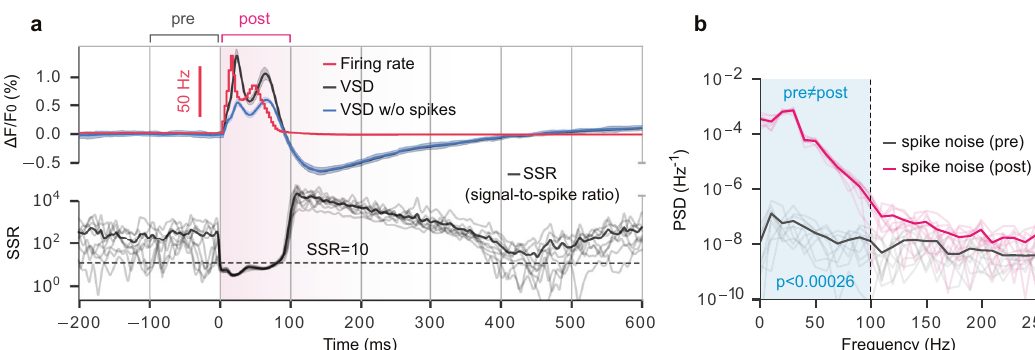
Fig. 4 Detectability of spiking activity in the VSDI signal. a Top: fi ring rate (red), VSD (black), and VSD computed excluding spikes (membrane potentials thresholded at − 55 mV, blue) for 200 ms of spontaneous activity followed by 600 ms of evoked activity. Bottom: signal-to-spike ratio. Noise here refers to “ spike noise ” , or contamination of putative subthreshold measurements by APs. Pale black lines are individual trials; dark line indicates mean. Dashed black line: signal-to-spike ratio = 10. b Power spectral density of spike noise computed for 100 ms prestimulus window (black), and 100 ms poststimulus window (magenta). Blue shaded box indicates frequencies for which pre- and poststimulus noise are signi fi cantly different. Dashed black line indicates frequency at which prestimulus noise and poststimulus noise are no longer meaningfully different (paired t test (two-sided), signi fi cance threshold = 0.01 adjusted to 2.6e-4 for multiple comparisons using Holm-Bonferroni